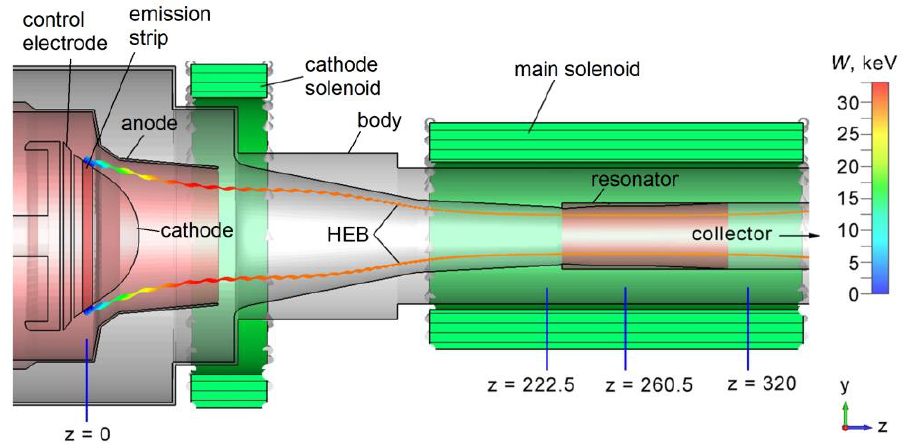
Fig. 1. Schematic drawing of the gyrotron model. Trajectories of electrons with different energies W .